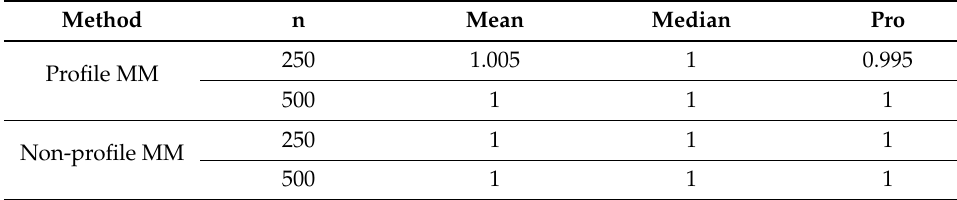
Table 3. The mean, median, and the proportion (Pro) of ˆ M in Scenario 2.